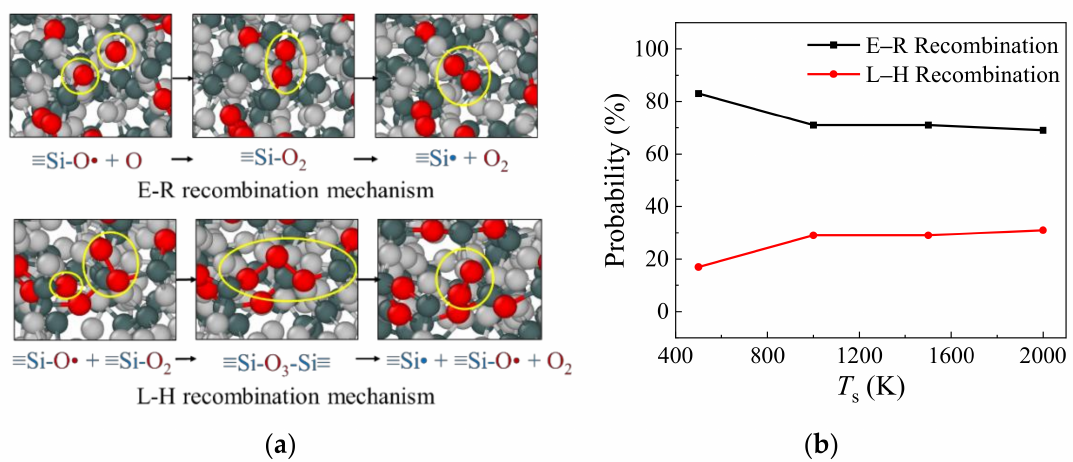
Figure 6. Surface catalysis recombination mechanism analysis by Models 1–4. ( a ) Illustration snap- shots for the E–R and L–H recombination mechanisms, and ( b ) the effect of surface temperature on the surface catalysis recombination